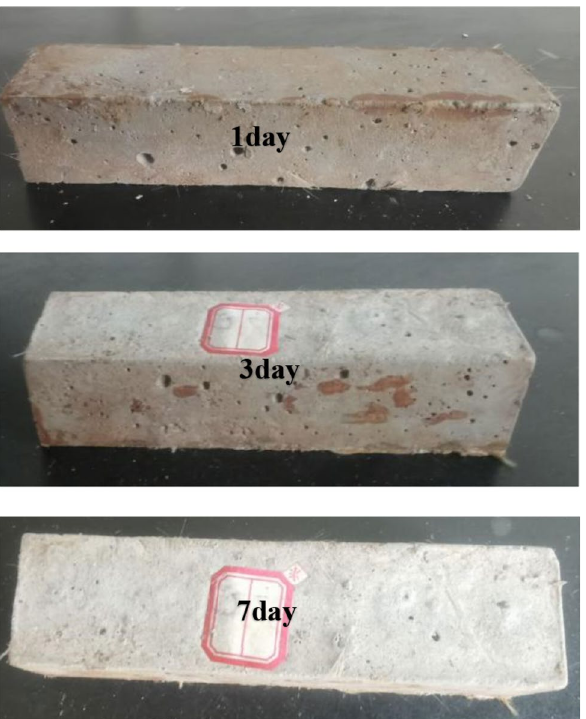
Figure 2. NBFM specimens of 1d, 3d, 7d maintenance